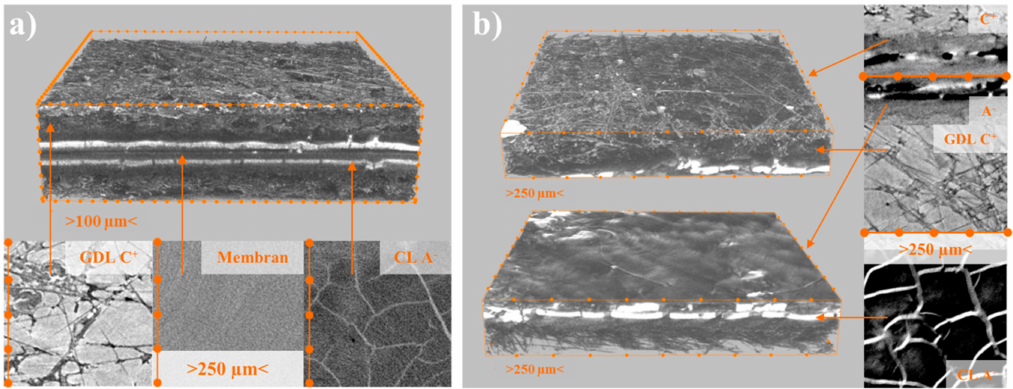
Figure 8. Reconstructed 3D images (CTVox) of the complete MEA: ( a ) FMT-B BoL and ( b ) FMT-B. Zoomed-in areas are reconstructed 2D images (DataViewer) of single layers (GDL, Membran, CL).